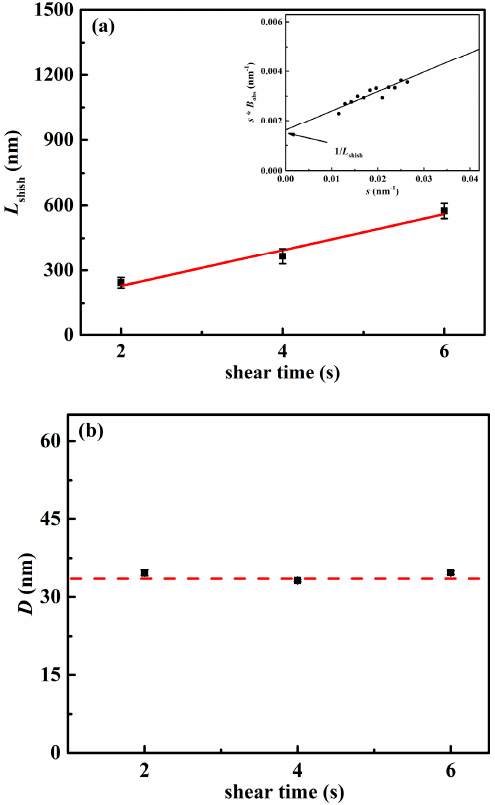
Figure 5. The change of shish ( a ) length L shish and ( b ) diameter D with the shear time. The length and diameter of shish were obtained after the shearing stopped immediately. The red solid line is the fitting result. The red dashed line is used to guide the eye. The insets show examples of using Equation (5) to obtain the shish length L shish .